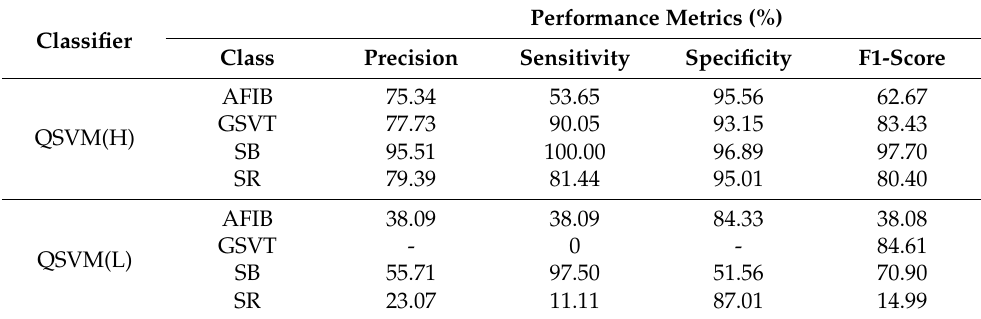
Table 4. Performance metrics of QSVM with the highest accuracy and lowest accuracy.